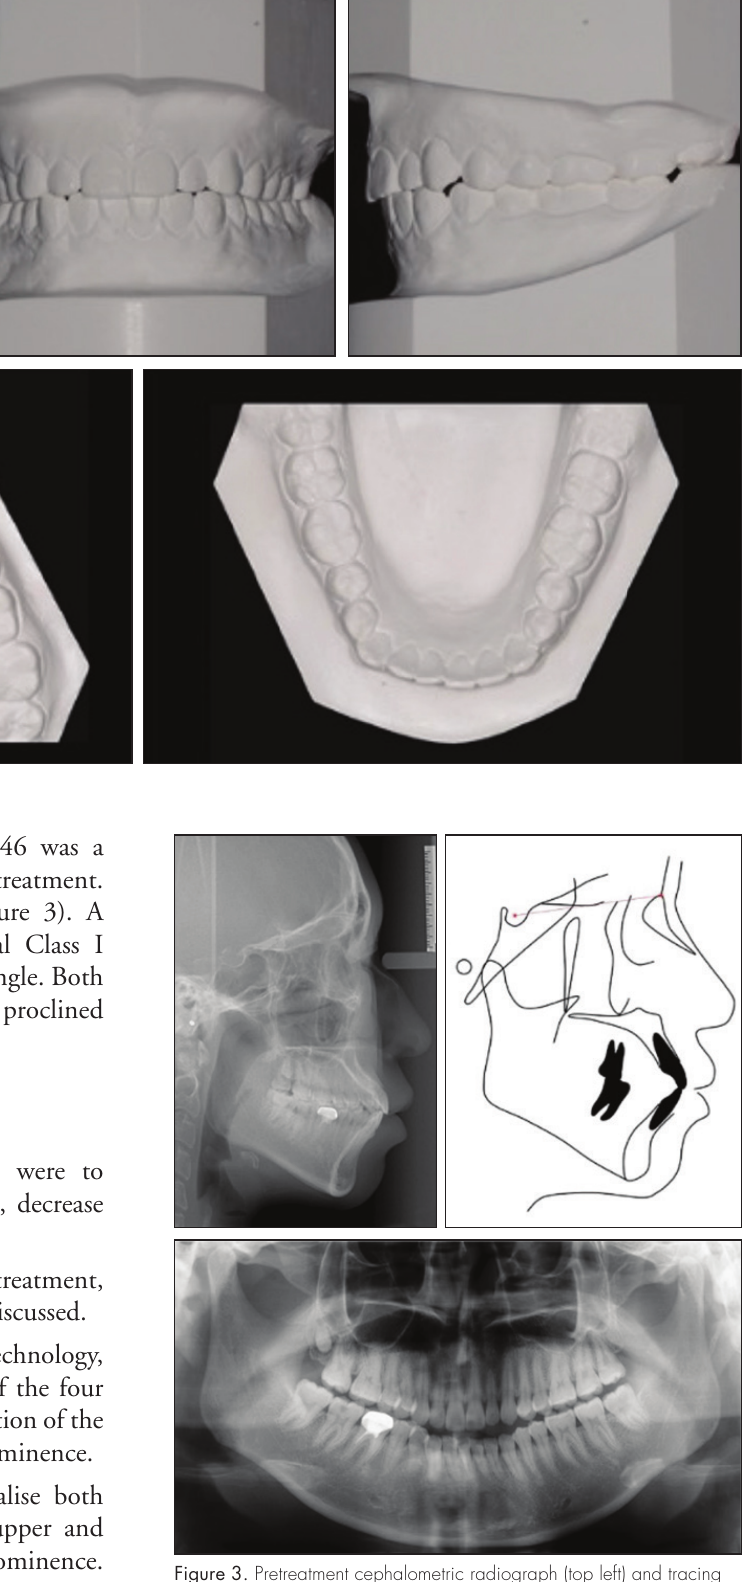
Figure 3. Pretreatment cephalometric radiograph (top left) and tracing (top right) and panoramic radiograph